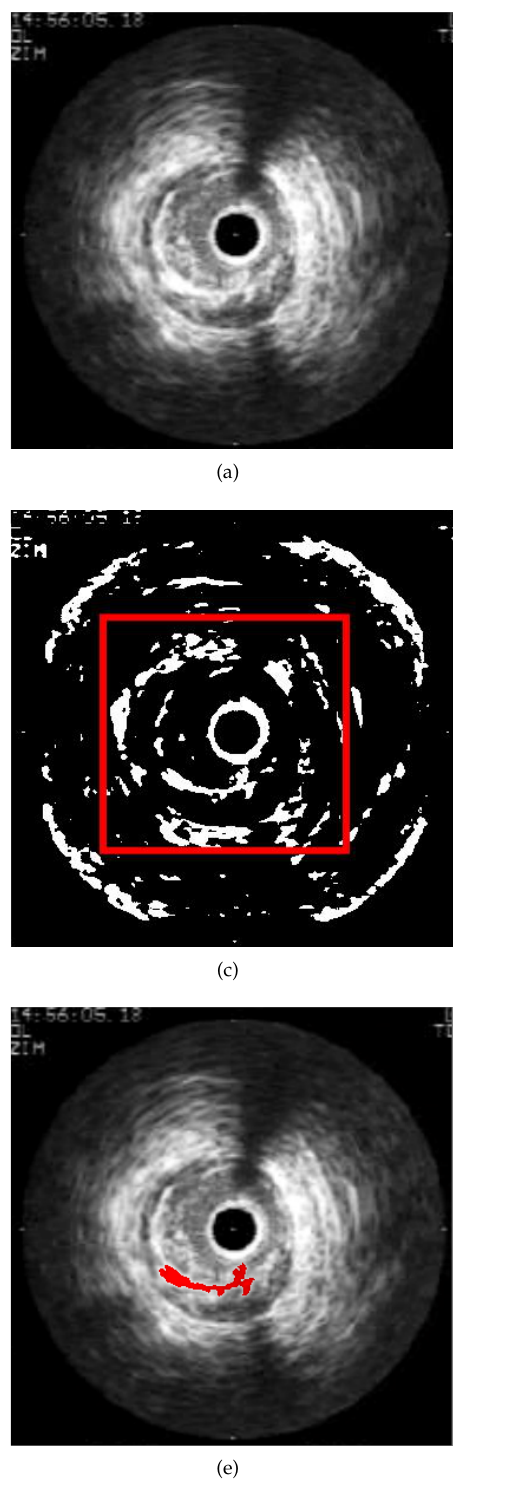
Figure 5. Steps to extract the information for the first layer according to the proposed algorithm: ( a ) Initial image; ( b ) Binarised image; ( c ) Selected zone for the analysis; ( d ) Boundaries detected by the Moore-Neighbour algorithm; ( e ) Atheroma spot selected by the